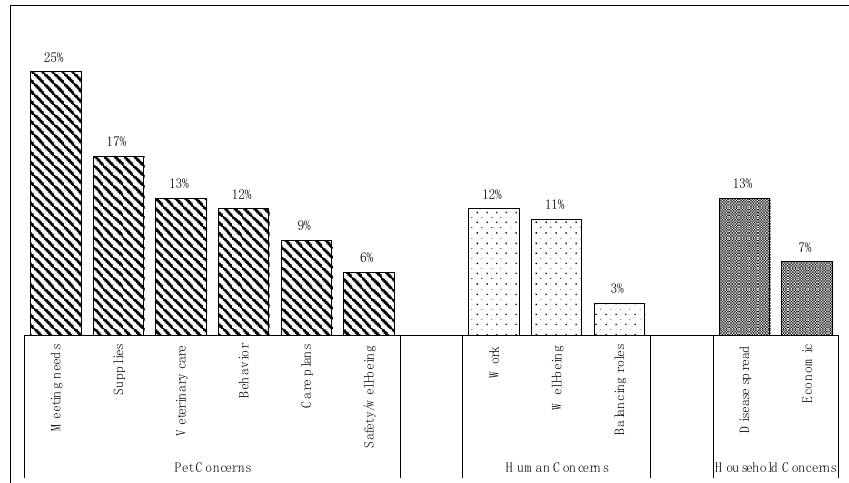
Figure 1. Relative frequencies of themes and sub-themes: concerns, difficulties, and stressors expressed by respondents related to caring for and living with pets during the COVID-19 pandemic.